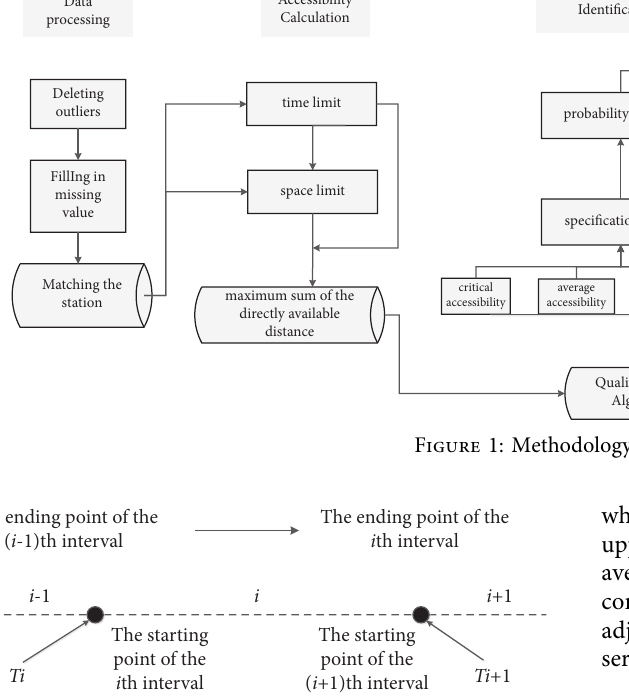
Figure 2: Interstation section running time